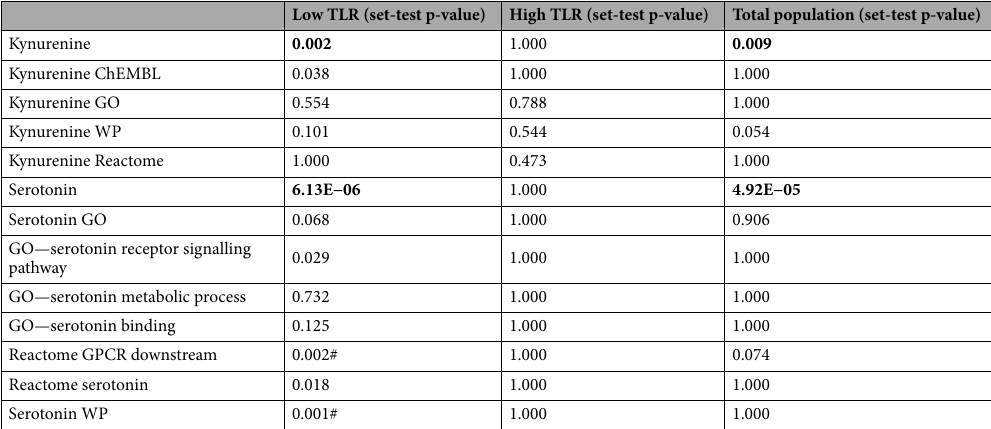
Table 2. Pathway- and subpathway-level set-test p-values for depressive symptoms for candidate pathways and their components with regard to dietary TLR subgroups. Values in bold indicate pathway-level significance for the serotonin and kynurenine pathways (p < 0.017), (#) denotes subpathway-level significance for serotonin pathway components (p < 0.0021). TLR denotes tryptophan to other LNAA ratio.